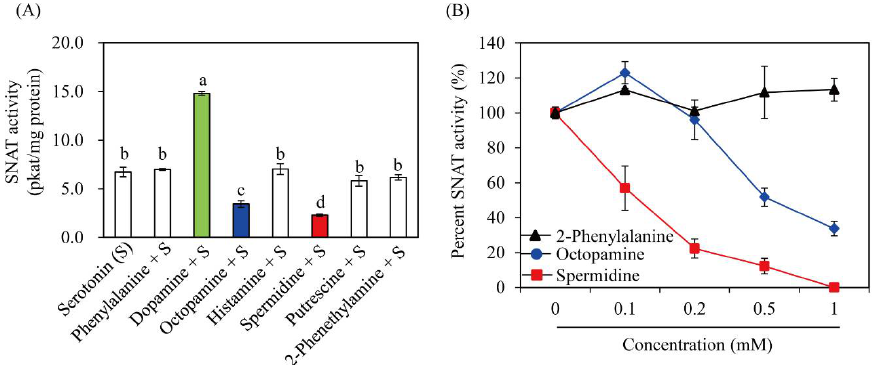
Figure 4. Effects of various substrates on SNAT activity. ( A ) SNAT enzyme activity of recombinant purified TvSNAT in the presence of serotonin (0.5 mM) and various amines (0.5 mM). Different letters indicate significant differences [ p < 0.05; analysis of variance (ANOVA), followed by Tukey’s honest significant difference (HSD) post hoc tests]. The green, blue and red colors emphasize compounds which alter SNAT activity.( B ) Dose-dependent inhibition of SNAT enzyme activity by spermidine or octopamine. SNAT activity was assayed in the presence of polyamines at various concentrations and expressed as a percentage relative to that in the absence of polyamines (Figure 4B). Data are the means ± standard deviation ( n = 3).